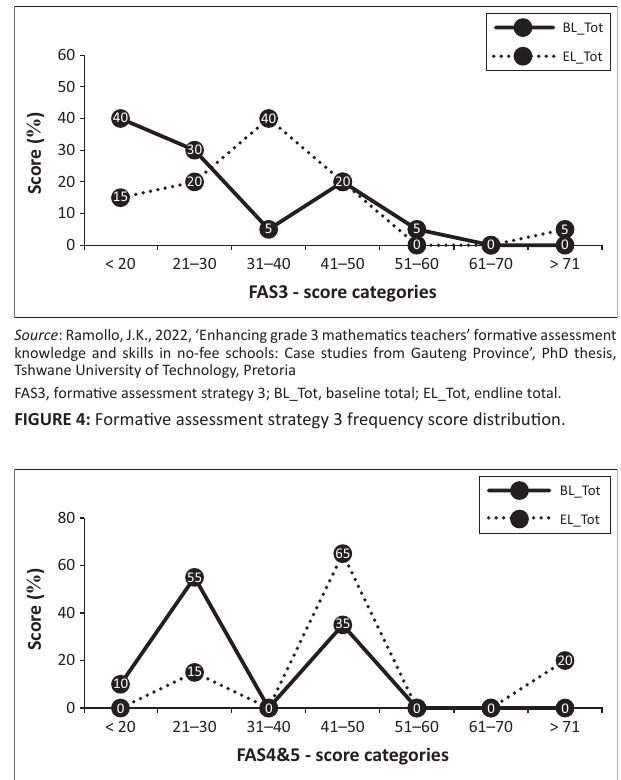
FIGURE 5: Formative assessment strategies 4 and 5 frequency score